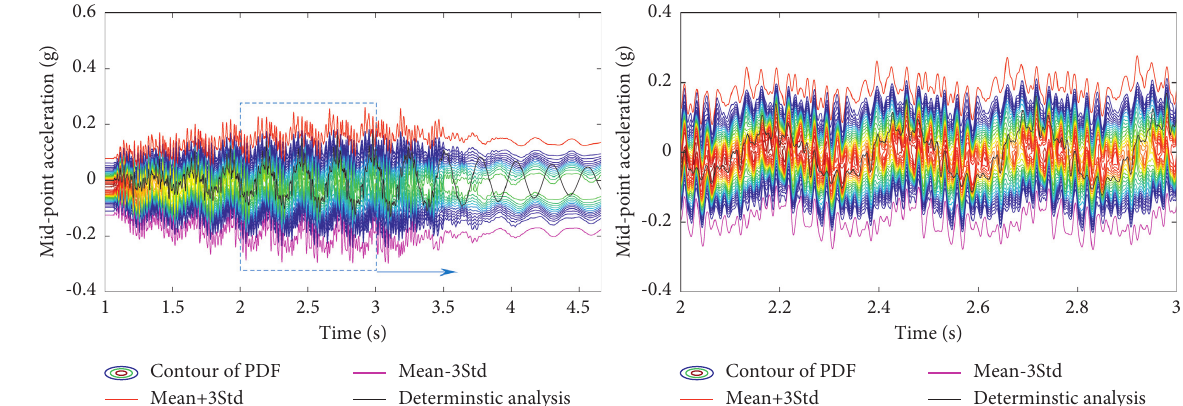
Figure 10: Contour of PDF of bridge midpoint acceleration for ( v ) � 340km/h.